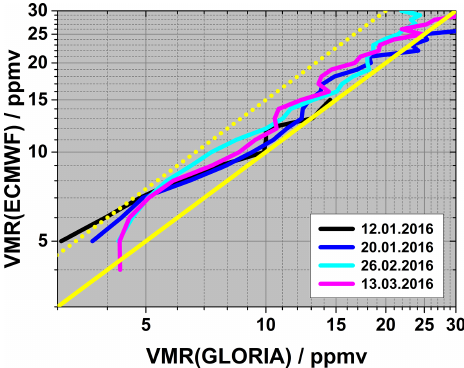
Figure 3. Overlay of mean correlations for flights from January to March 2016 (i.e., cyan lines in Figs. 1e and 2f, i, l).